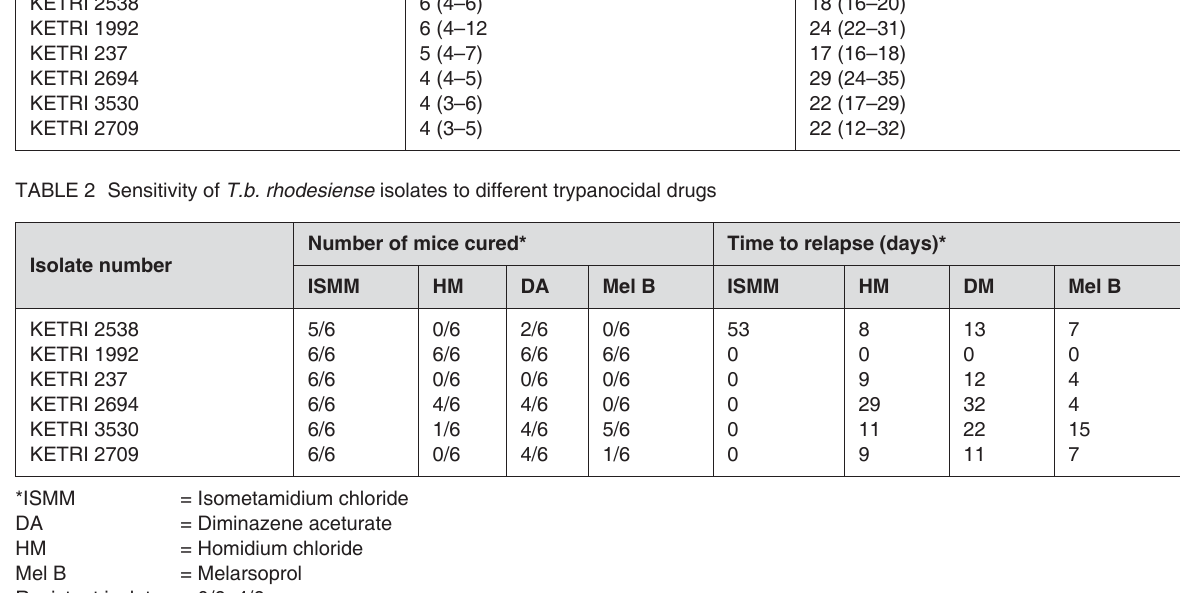
TABLE 1 Pathogenicity of the different T.b. rhodesiense isolates Isolate number Mean prepatent period days (range)